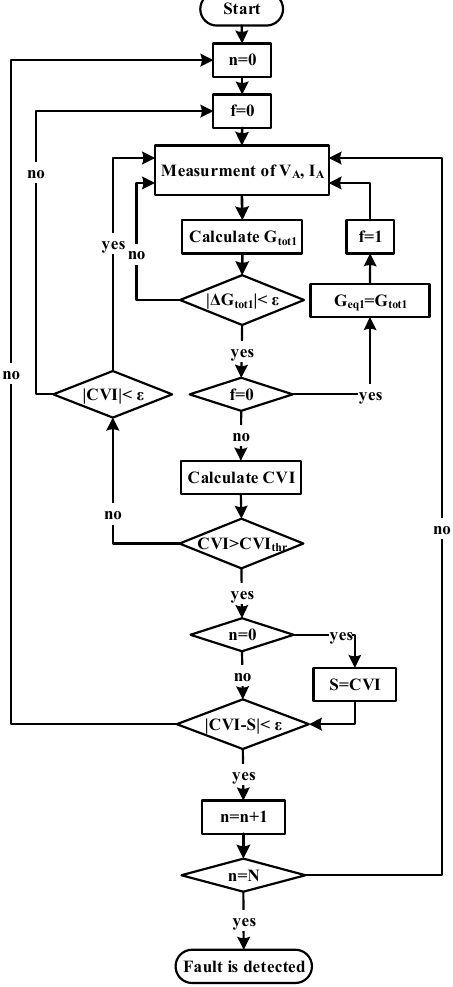
Figure 13. Flowchart of backup protection scheme.